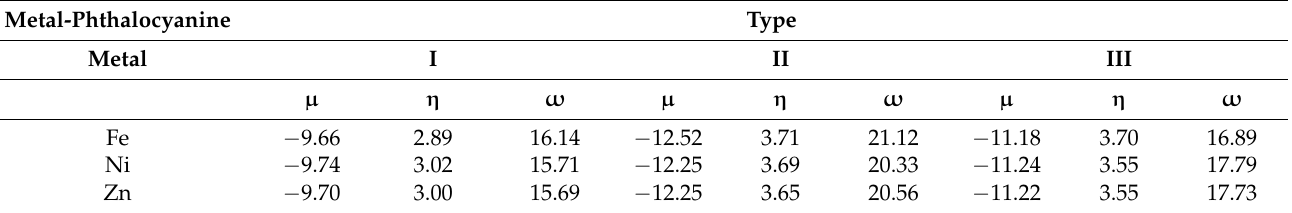
Table 4. Chemical potential ( µ ), hardness ( η ), and electrophilicity ( ω ) (eV) (HF/LanL2DZ level of theory).